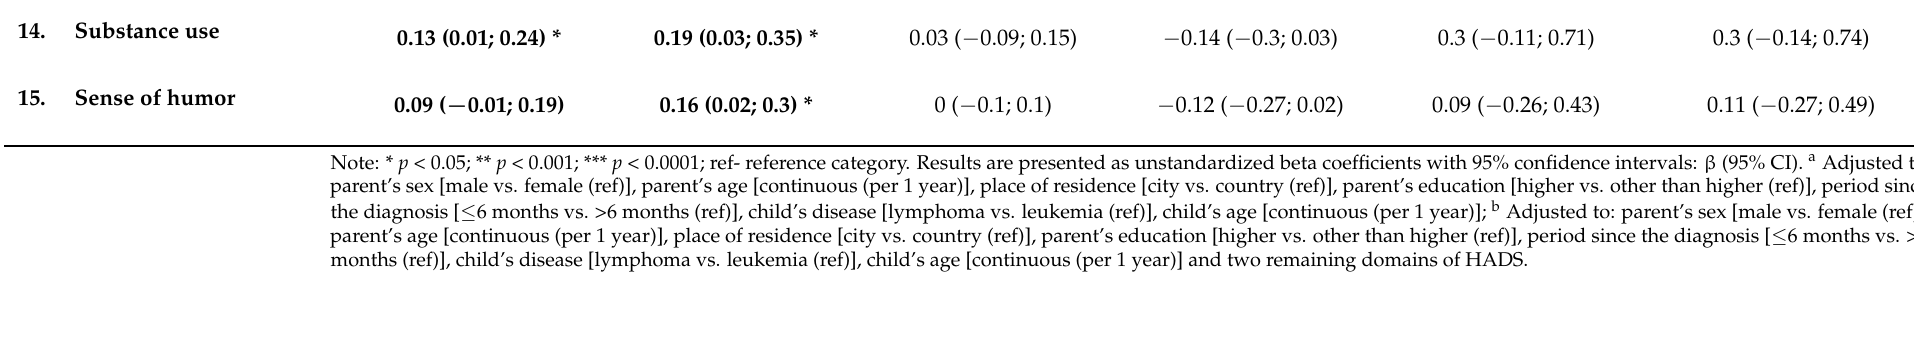
Table 9. The association between the particular category of depression and anxiety and the use of particular coping strategies—multivariable